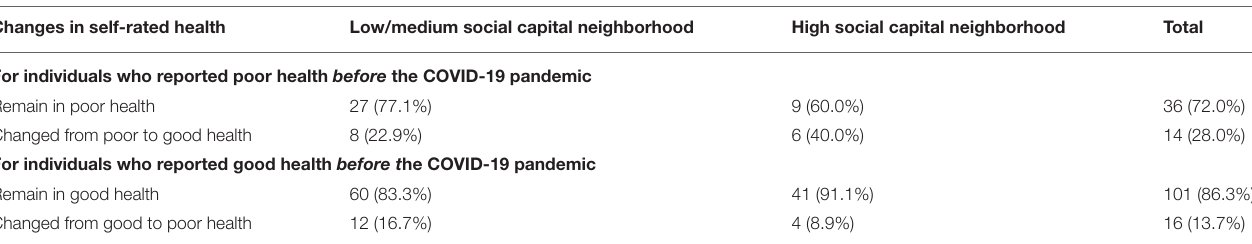
TABLE 3 | Changes in self-rated health during the COVID-19 pandemic across different neighborhoods. Changes in self-rated